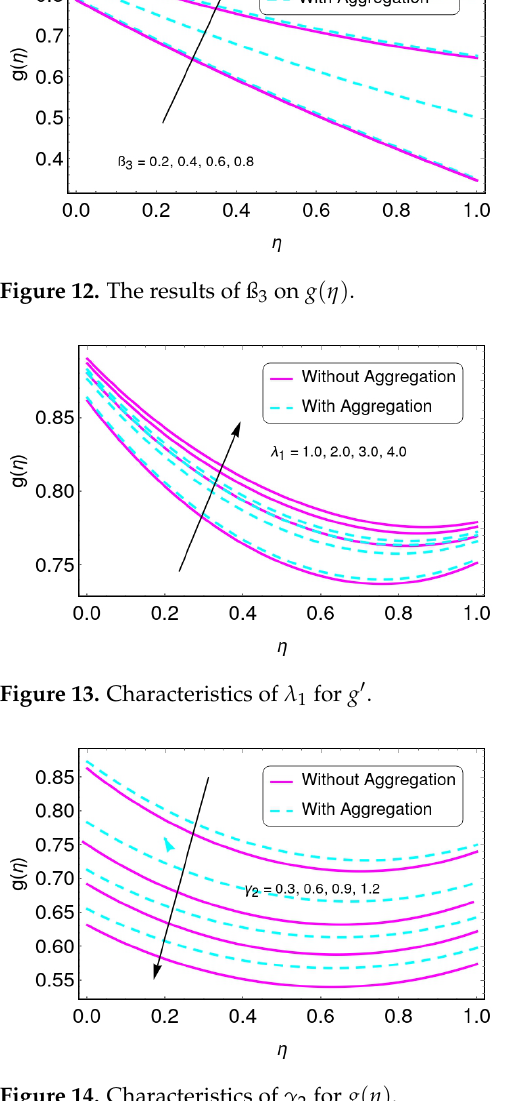
Figure 14. Characteristics of γ 2 for g ( η )